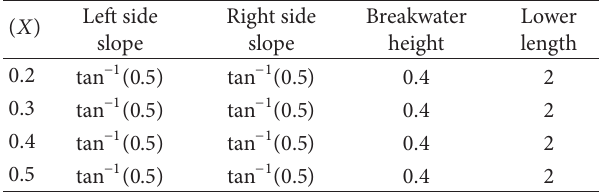
Figure 14: Free surface profile at length ratio 6.33. Table 7: Breakwater characteristics.